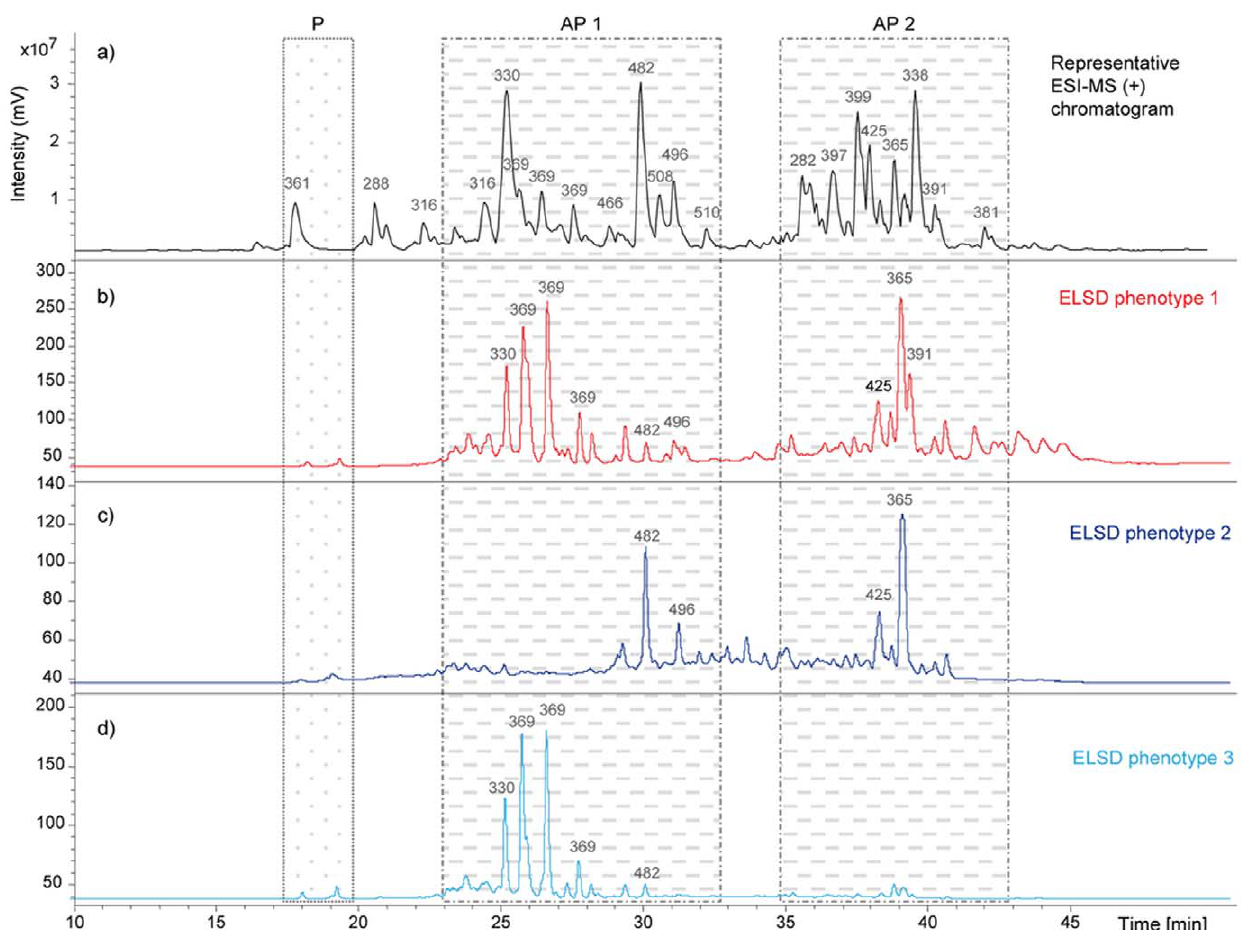
Figure 3. Metabolic fingerprints of Oscarellabalibaloi . Representative LC-MS chromatogram (a) of Oscarella balibaloi and three metabolic phenotypes ( 1 , 2 and 3 ) indicated by their respective ELSD chromatograms (b, c, d). On the LC-MS and LC-ELSD chromatograms major m/z are indicated above peaks.